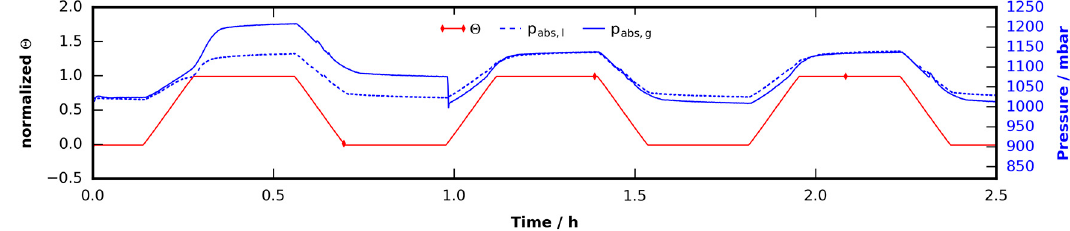
Figure 8. Thermal cycling of THF clathrate samples subjected to a trapezoidal temperature profile with base temperature 243 K, peak temperature 283 K, and a heating/cooling rate of 5 K/min: (1) The sample whose pressure signal has subscript “g” was stored in a freezer for one week before being loaded into the sample cell. Contact with liquid nitrogen was limited to a few seconds during the loading process. After one hour, the pressure inside the cell was relieved by quickly opening and closing it; (2) The pressure signal with subscript “l” stems from a sample which was stored in liquid nitrogen for four days after being freshly formed.